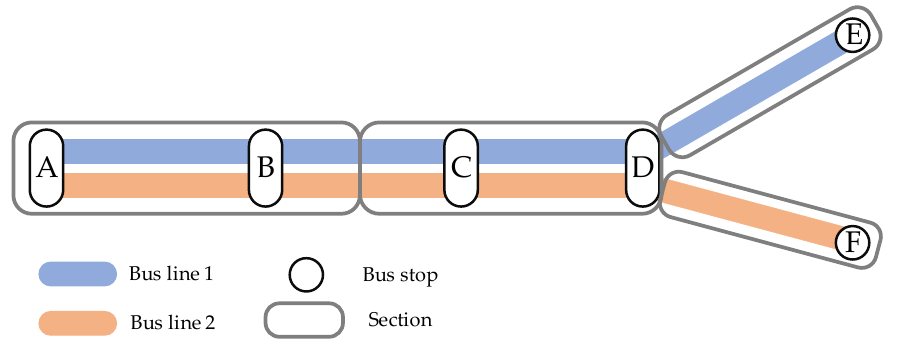
Figure 2. Segmentation of bus lines into sections.